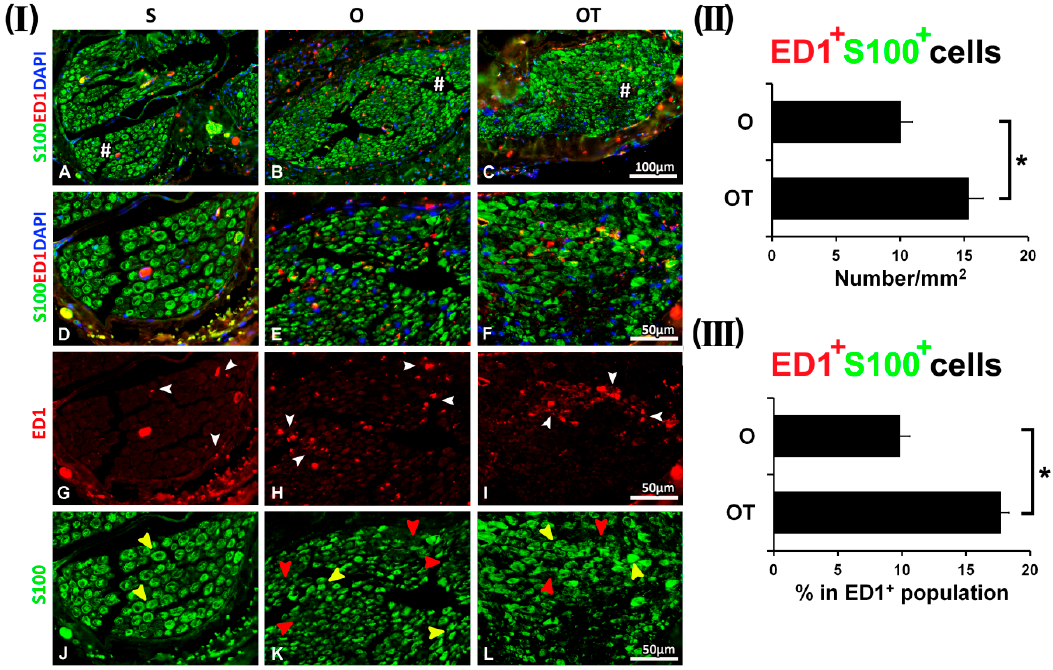
Figure 1. Effect of peripheral nerve injury (PNI) and treatment with B vitamins on Schwann cells (SCs)-macrophages co-localization at the 1st day post operation (dpo). ( I ) Cross sections of femoral nerve obtained from sham (S), operated (O, the transection of the motor branch and immediate reconstruction using termino-terminal anastomosis) and operated and treated with the vitamin B complex (B1, B2, B3, B5, B6, and B12) (OT) groups were stained for ED1 (anti-CD68, red) antibody, a marker of activated macrophages. Anti-S100 antibody (green) was used as a marker of SCs. The sections were counterstained with DAPI (blue) to visualize cell nuclei. The representative images demonstrated that in the S group only a few ED1 + cells were detected ( G , white arrow heads), most of the SCs had morphology of myelin-forming SCs and were intensively stained with S100 ( J , yellow arrow heads). There was negligible overlapping of ED1 and S100 immunoreactivity ( A – D ). In the O group, ED1 + macrophages with round and oval morphology of the M1 type were abundantly present ( H , white arrow heads), particularly around the dark spots ( E , K , red arrow heads), consisting of SCs with low S100 immunoreactivity. S100 + cells ( K , yellow arrow heads) of myelinating SCs morphology were also seen, but without ED1 and S100 immunoreactivity overlapping ( B , E ). After one vitamin B complex injection, the number of ED1 + cells was decreased ( I , white arrow heads). S100 + cells of the myelinating SCs morphology were also present ( F and L , yellow arrow heads). # indicates where the high magnification micrographs were taken from. Scale bars: A – C = 100 µm, D – L = 50 µm. ( II ) The quantification of double positive ED1 + /S100 + cells from the O and OT experimental groups is depicted in the graphs (black bars) as a number of double positive cells/mm 2 and ( III ) the percentage of double positive cells in the ED1 + cells population. The data are shown as the mean ± SEM of three independent experiments (three images/group/independent experiment were captured). Statistical analysis was done using a two-sided Student’s t-test (* p < 0.05 vs. O group, as indicated at the graphs).